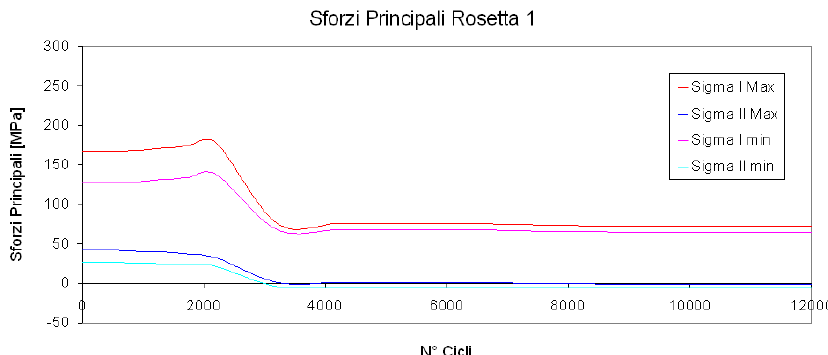
Figura 19: Andamento degli sforzi principali rilevati dalla Rosetta 1 in funzione del N° di cicli: le curve di colore rosso/viola e